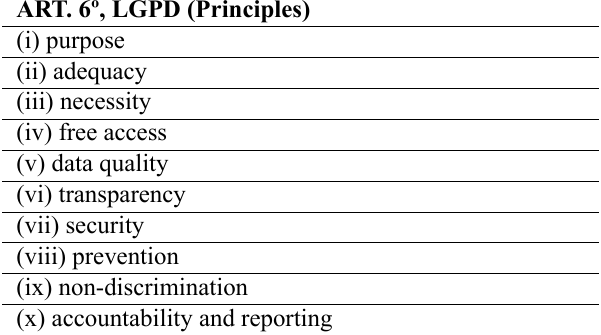
Table 3. Principles to be observed in the operations of processing personal data provided by